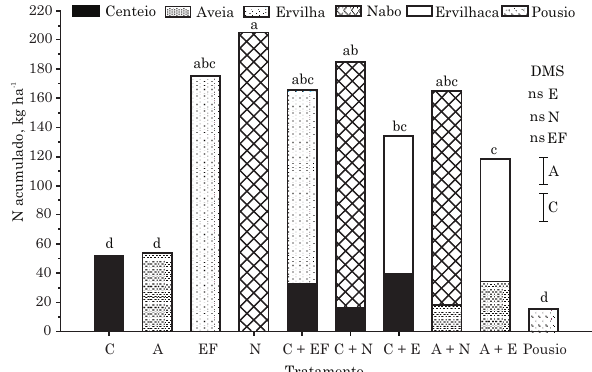
Figura 1. Acúmulo de nitrogênio (N) na parte aérea das plantas de cobertura, em cultura pura e em consórcio. Médias das quantidades totais de N seguidas de mesma letra não diferem entre si pelo teste de Tukey a 5 %. As barras verticais correspondem à diferença mínima significativa (Tukey 5 %) para a quantidade de N acumulada por cada espécie. ns=não significativo. C=centeio; A=aveia-preta; EF=ervilha forrageira; NF=nabo forrageiro; E=ervilhaca